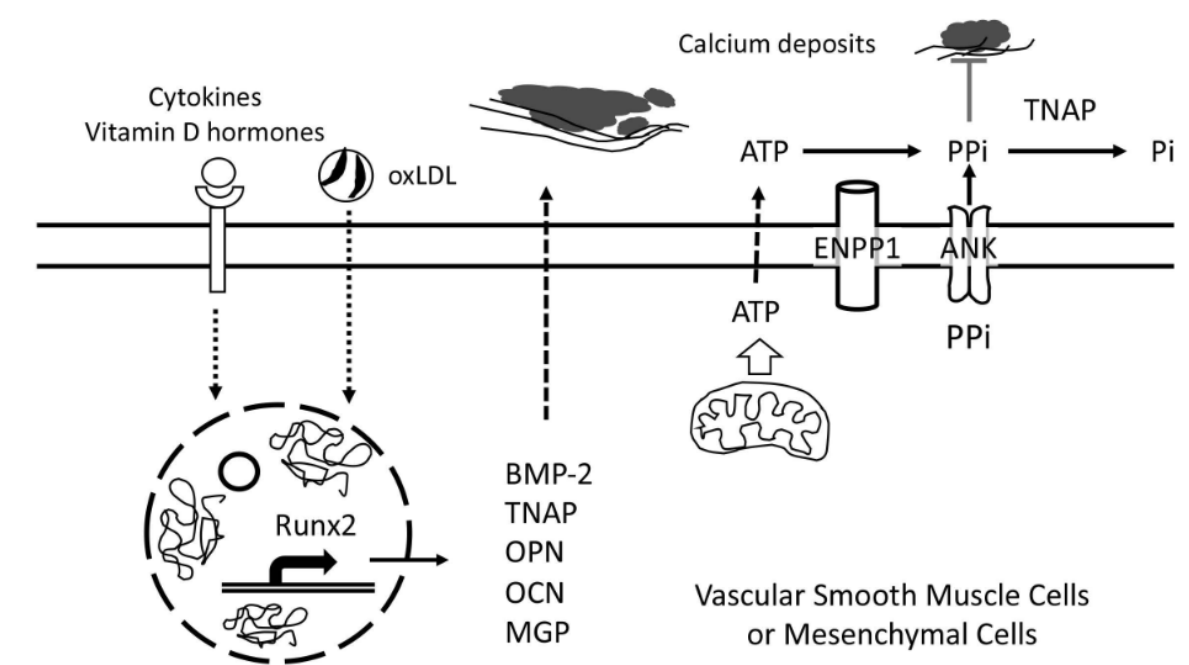
Figure 1. Schematic of some core biomolecules in cardiovascular calcification. Physiologically, extraskeletal cells prevent matrix calcification by producing an inhibitor of calcification, pyrophosphate (PPi). Levels of extracellular PPi is maintained by a plasma membrane transporter, ANK, as well as by a plasma membrane-bound ectoenzyme, ENPP1. In pathological conditions, inflammatory (cytokines, oxLDL), and hormonal (vitamin D hormones) stimuli activate the runt-related transcription factor 2 (Runx-2)-mediated transcription of core biomolecules involved in matrix mineralization, including bone morphogenetic protein (BMP)-2, tissue-nonspecific alkaline phosphatase (TNAP), OPN, OCN, and MGP. The upregulation of TNAP, which is packaged in matrix vesicles and secreted extracellular compartments, contributes to vascular calcification by breaking down PPi.